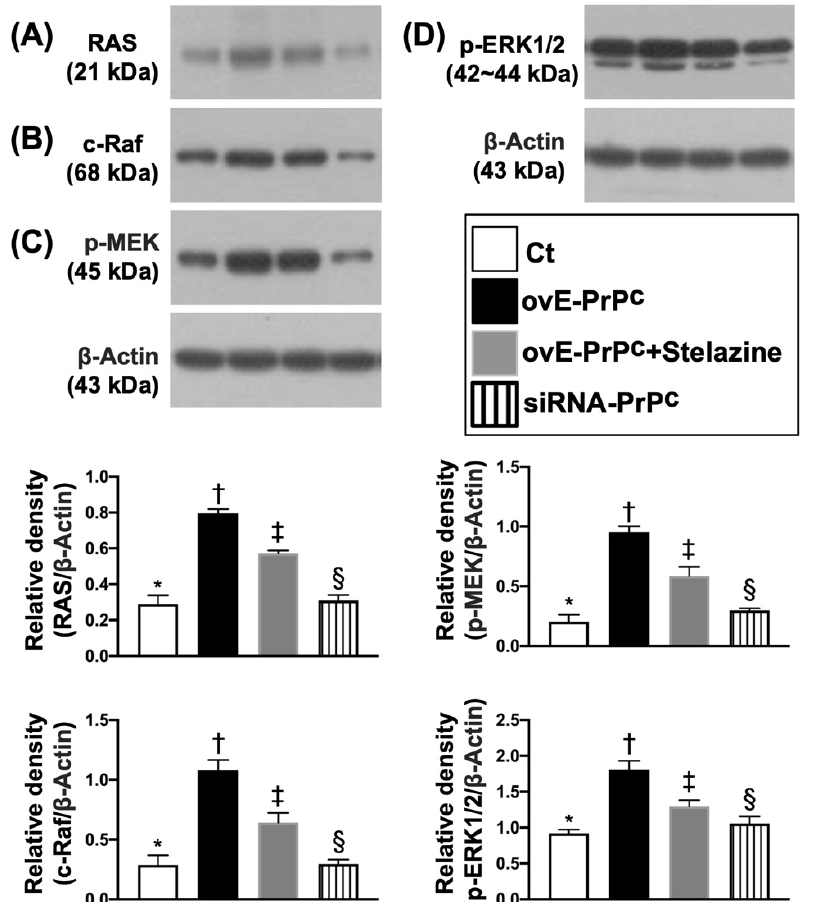
Figure 3. PrP C -regulated epidermal growth factor (EGF) signaling pathway in H9C2 cells. ( A ) Protein expression of RAS, * vs. other groups with different symbols (†, ‡, §), p < 0.0001. ( B ) Protein expression of cellular (c)-Raf, * vs. other groups with different symbols (†, ‡, §), p < 0.0001. ( C ) Protein expression of phosphorylated (p)-MEK, * vs. other groups with different symbols (†, ‡, §), p < 0.0001. ( D ) Protein expression of p-ERK)1/2, * vs. other groups with different symbols (†, ‡, §), p < 0.0001. All statistical analyses were performed by one-way ANOVA, followed by Bonferroni multiple comparison post-hoc test (n = 3 for each group). Symbols (*, †, ‡, §) indicate significance (at 0.05 level). Ct = control group (i.e., H9C2 cells only); ovE-PrP C = overexpression of PrP C in H9C2 cells; siRNA-PrP C = siRNA knockdown PrP C in H9C2 cells; Ras = Rat sarcoma; ERK = extracellular signal-regulated protein kinase; MEK = mitogen-activated protein kinase kinase; Raf = proto-oncogene c-RAF.